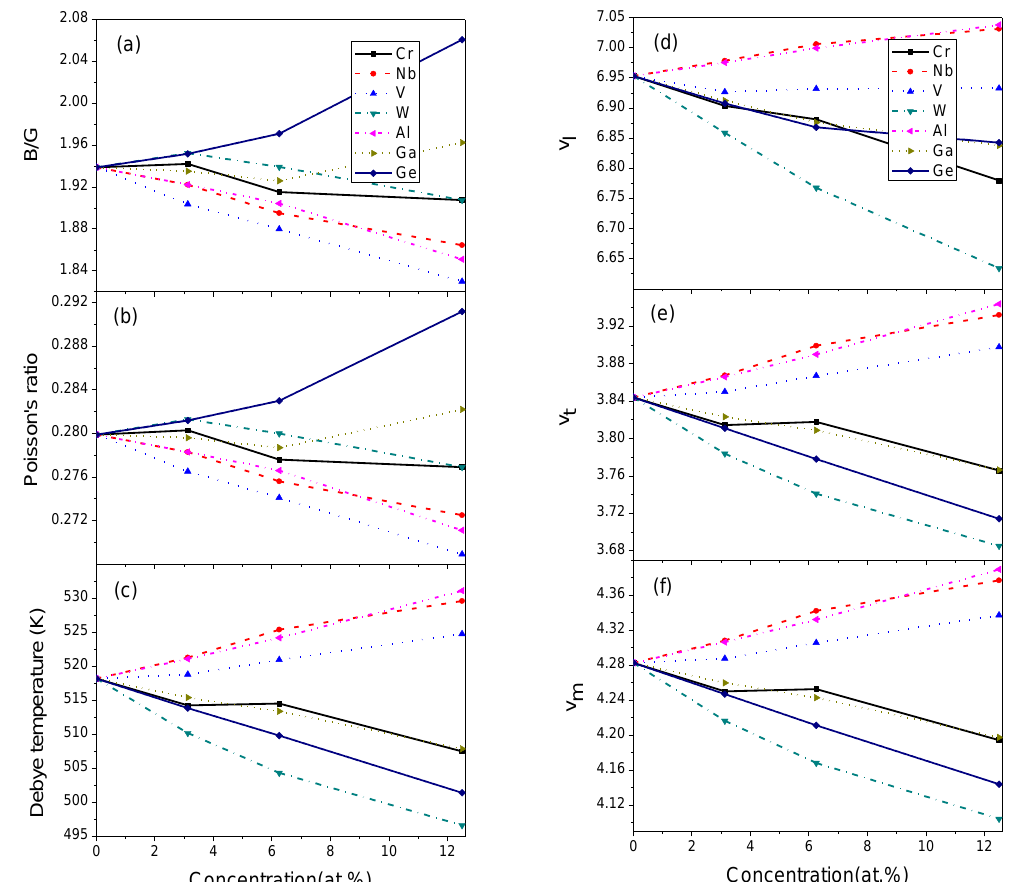
Figure 4. B/G, Poisson ratio, wave velocities and Debye temperatures of doped Mo 3 Si. ( a ) B/G ( b ) Poisson ratio ( c ) Debye temperatures ( d ) v l ( e ) v t ( f ) v m